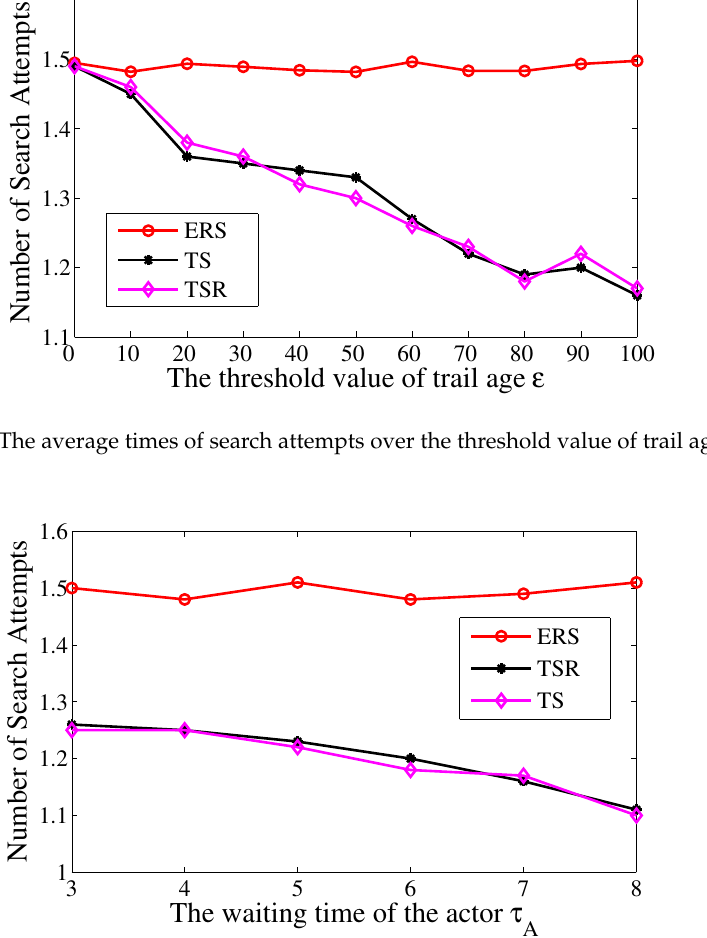
Figure 10. The average times of search attempts over the waiting time of actor τ A